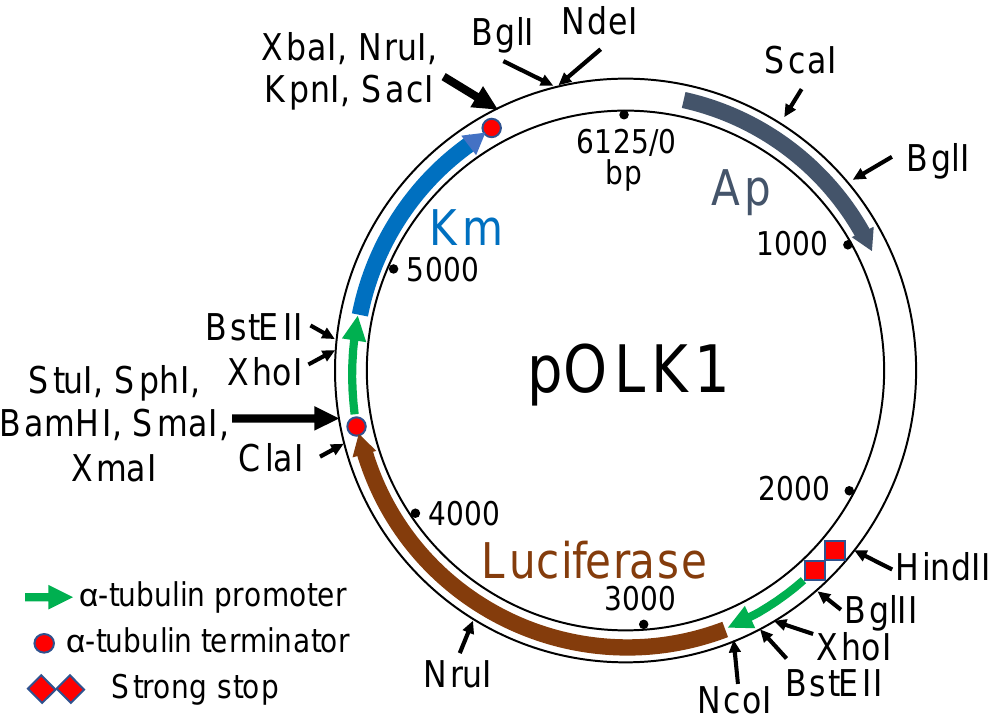
Figure 1. pOLK vectors used for transformation. Km—eukaryotic G418 (or kanamycin) resistance. Synthetic sequences for the visible (Luciferase) and algal selectable (Km) markers were inserted in the pUC57 cloning vector between the HindIII–BamHI sites in the polylinker. Commonly used restriction endonucleases cutting once or twice are shown, and thicker arrows indicate multiple-enzyme cloning sites. In the vectors pOLK2, pOLK3, pOLK4 and pOLK5 (not shown), the BglII–NcoI fragment was replaced by promoter sequences from Histone 2A, Histone 3, Ubiquitin and Thioredoxin, respectively (the sequences of pOLK1 and other component parts are listed in Supplementary File 1, Table S1).